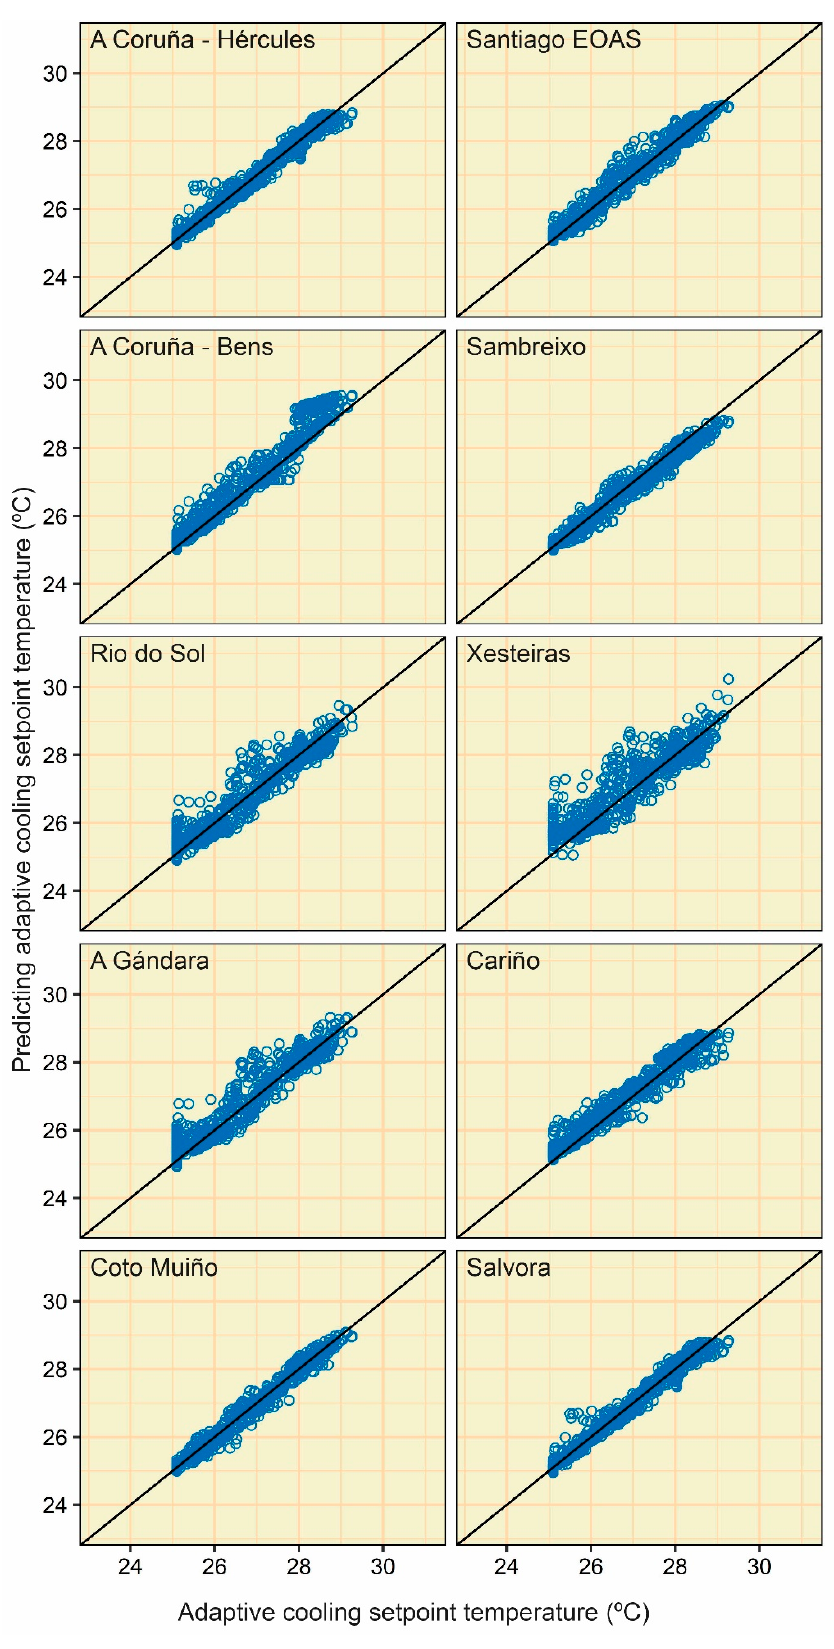
Figure A11. Point clouds between the actual and predicting adaptive cooling setpoint temperature values (category II) of the MLP (approach 2).